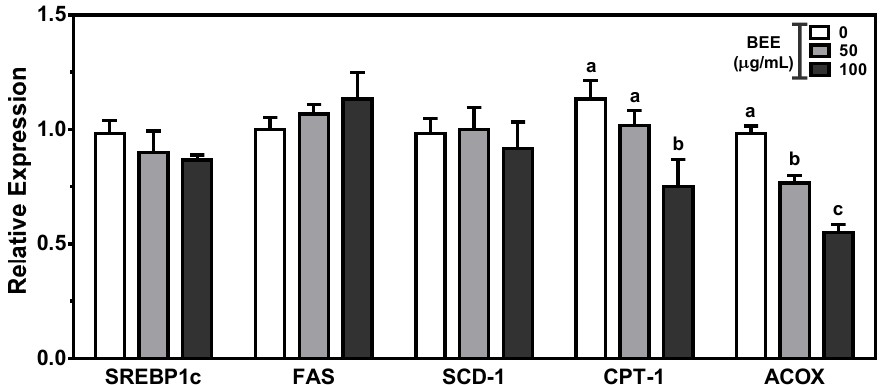
Figure 4. The expression of genes for fatty acid metabolism in BEE-treated HepG2 cells. Cells were treated with 50 or 100 µ g/mL of BEE for 24 h. The mRNA abundance was measured by qRT-PCR analysis. Data are expressed as relative expressions to control. Different letters indicate significant differences ( p < 0.05). Values are means ± S.E.M. n = 6.